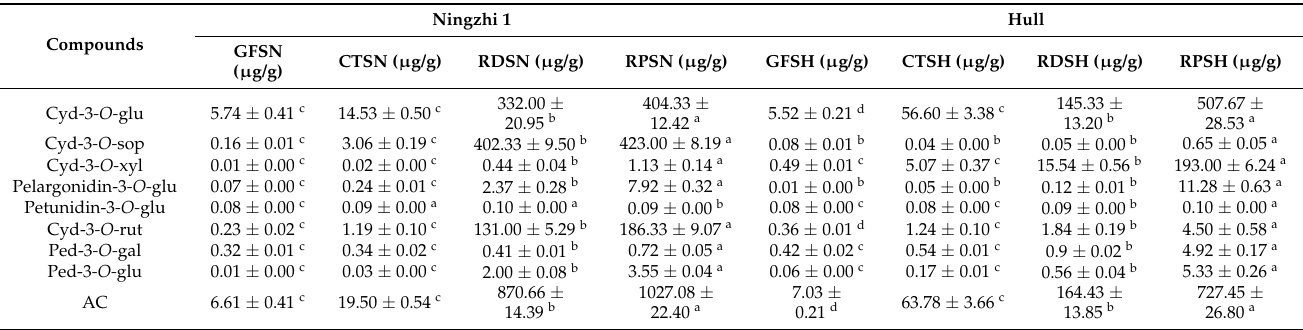
Table 2. Variation of anthocyanin content in Ningzhi 1 and Hull blackberry fruit at different develop- mental